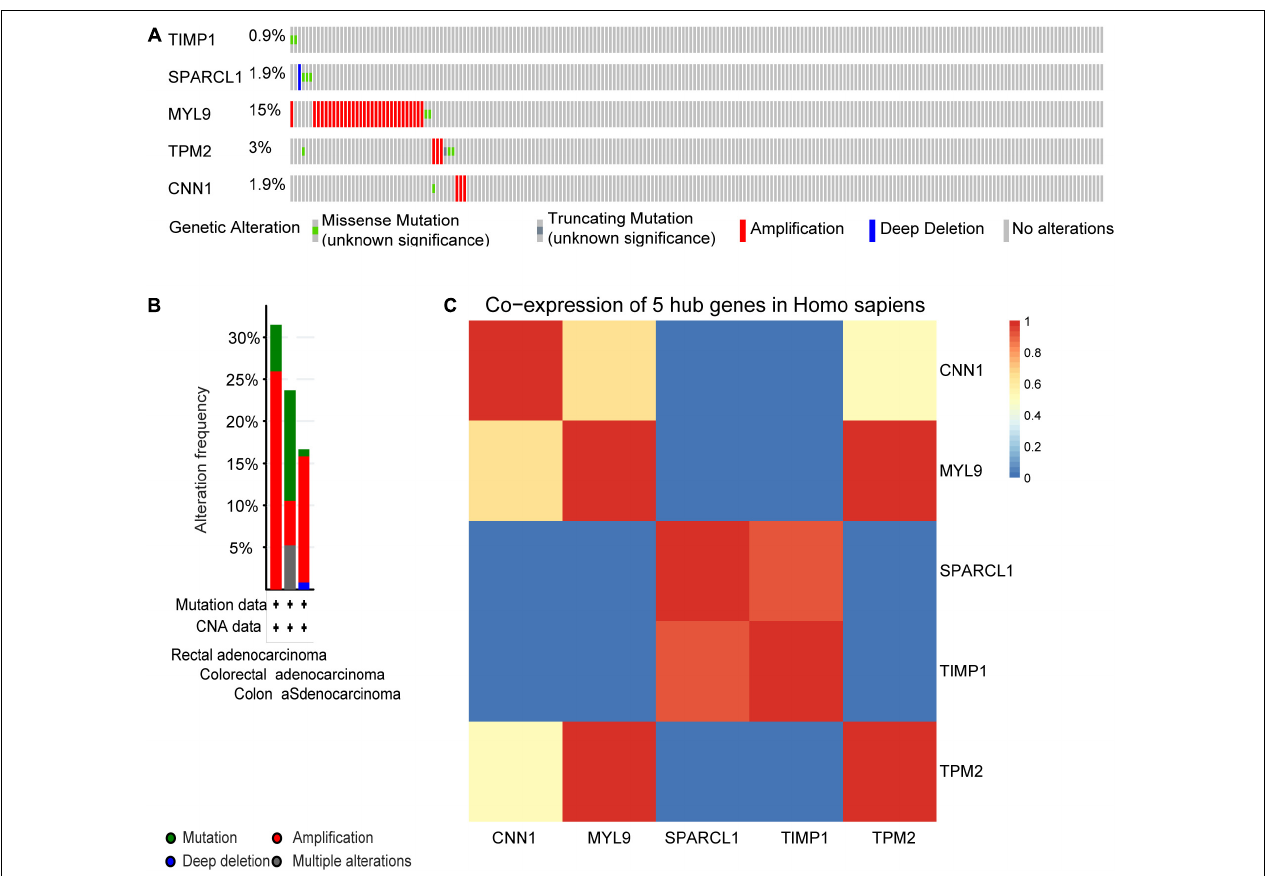
FIGURE 9 | Genetic alteration information and co-expression analysis of the five poor prognostic genes in CRC. (A) A visual summary across a set of CRC (data from colorectal adenocarcinoma, TCGA, Nature 2012) showed the genetic alterations connected with the five hub genes which were altered in 49 (22.7%) of 212 sequenced patients (212 in total). (B) An overview of changes in the five hub genes in the genomics datasets of CRC in TCGA database. Summary for rectal adenocarcinoma: gene altered in 31.48% of 54 cases, mutation 5.56% (3 in 54 cases), amplification 25.93% (14 in 54 cases). Summary for colorectal adenocarcinoma: gene altered in 23.68% of 38 cases, mutation 13.16% (5 in 38 cases), amplification, 5.26% (2 in 38 cases), multiple alterations5.26% (2 in 38 cases). Summary for colon adenocarcinoma: gene altered in 16.67% of 120 cases, mutation, 0.83% (1 in 120 cases), amplification, 15% (18 in 120 cases), deep deletion 0.83% (1 in 120 cases). (C) The co-expression analysis of five hub genes using the STRING online